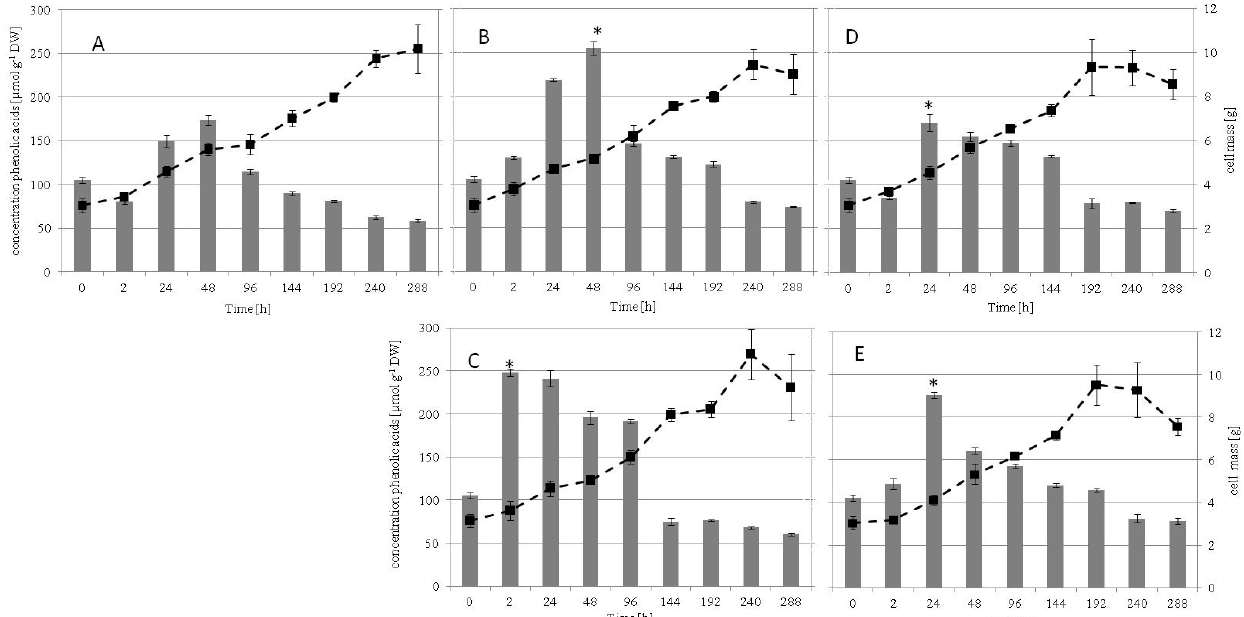
Figure 1. Multicomparison between growth and accumulation of phenolic acids in grape cells. The bars represent the concentration of phenolic acids and the lines represent